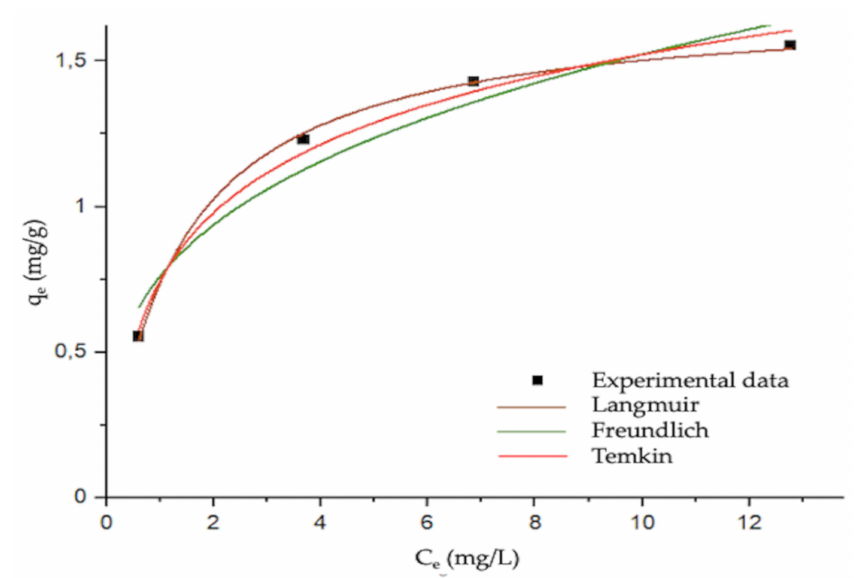
Figure 5. Nonlinear isotherms for the adsorption of DCF onto COSMOS (sample A). The isotherm was reported at a fixed T (room temperature equal to 298 K). The fit was performed by Origin v.15.0